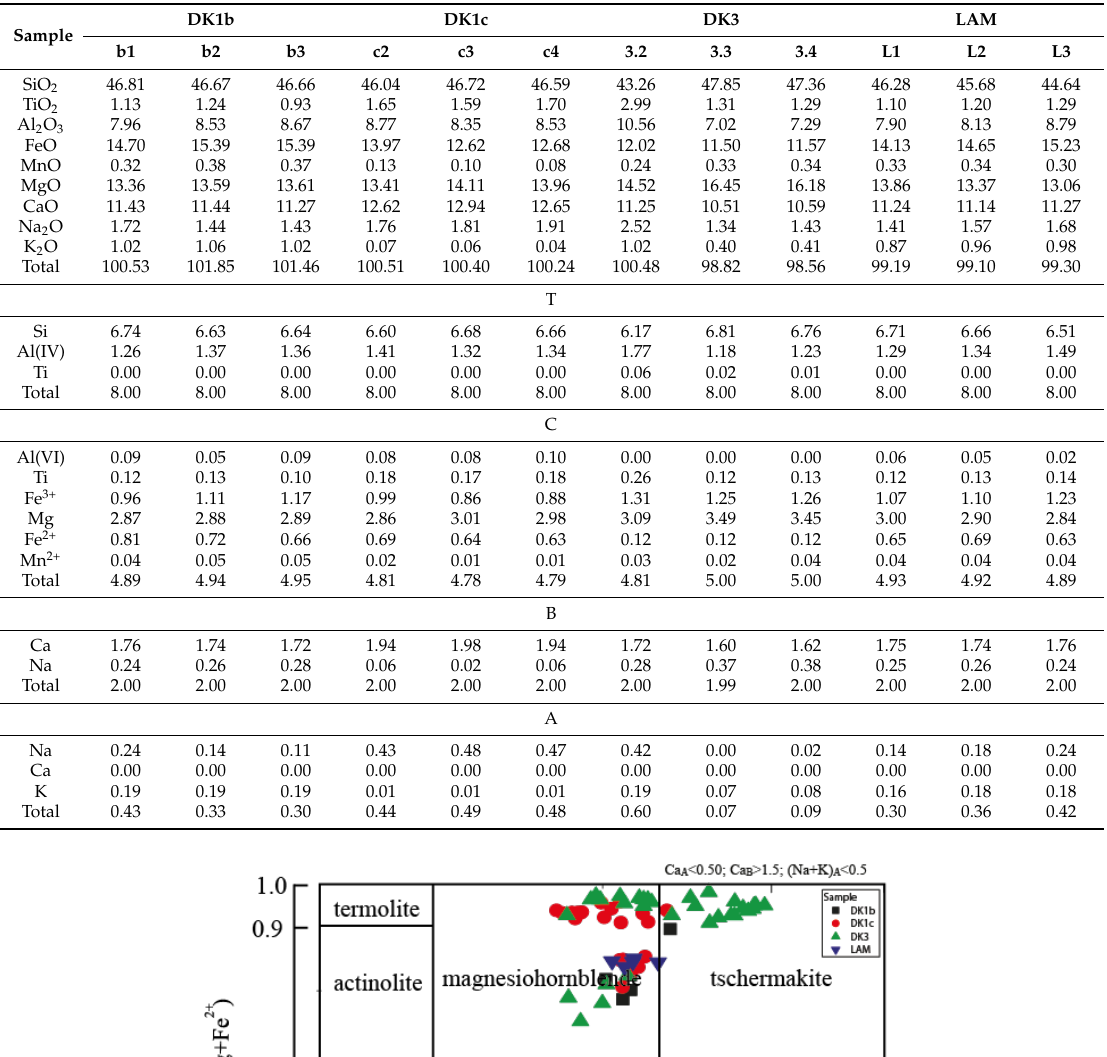
Table 2. Representative microprobe analysis of amphiboles in Sungun deposit late dykes. Cation calculation is based on 23 oxygen.